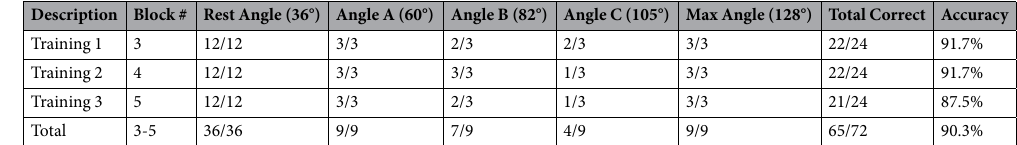
Table 1. Summary of Participant Accuracy Over the Three Training Blocks.